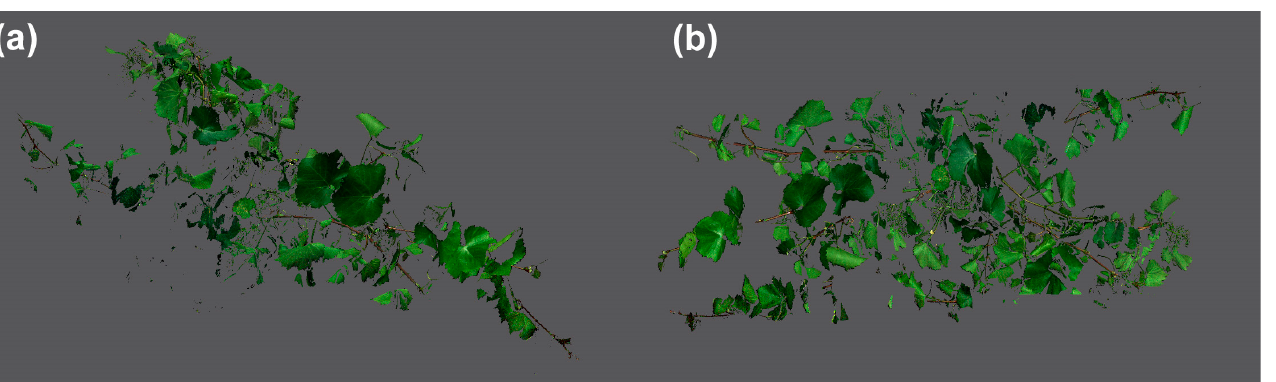
Figure 2. Exemplary display (3D model) of the representative vine (obtained with PlantEye F500 multispectral 3D scanner (Phenospex, Heerlen, The Netherlands)) at the SUPREHILL CZO at as- sumed maximum Leaf Area Index (LAI); ( a ) side view; ( b ) top view.